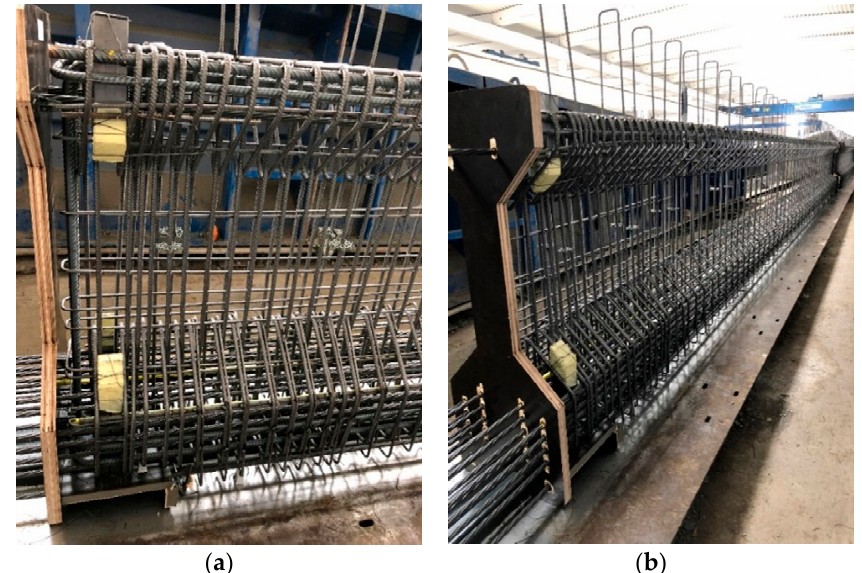
Figure 2. Rebar and strand configuration: ( a ) End zone; ( b ) Full beam.